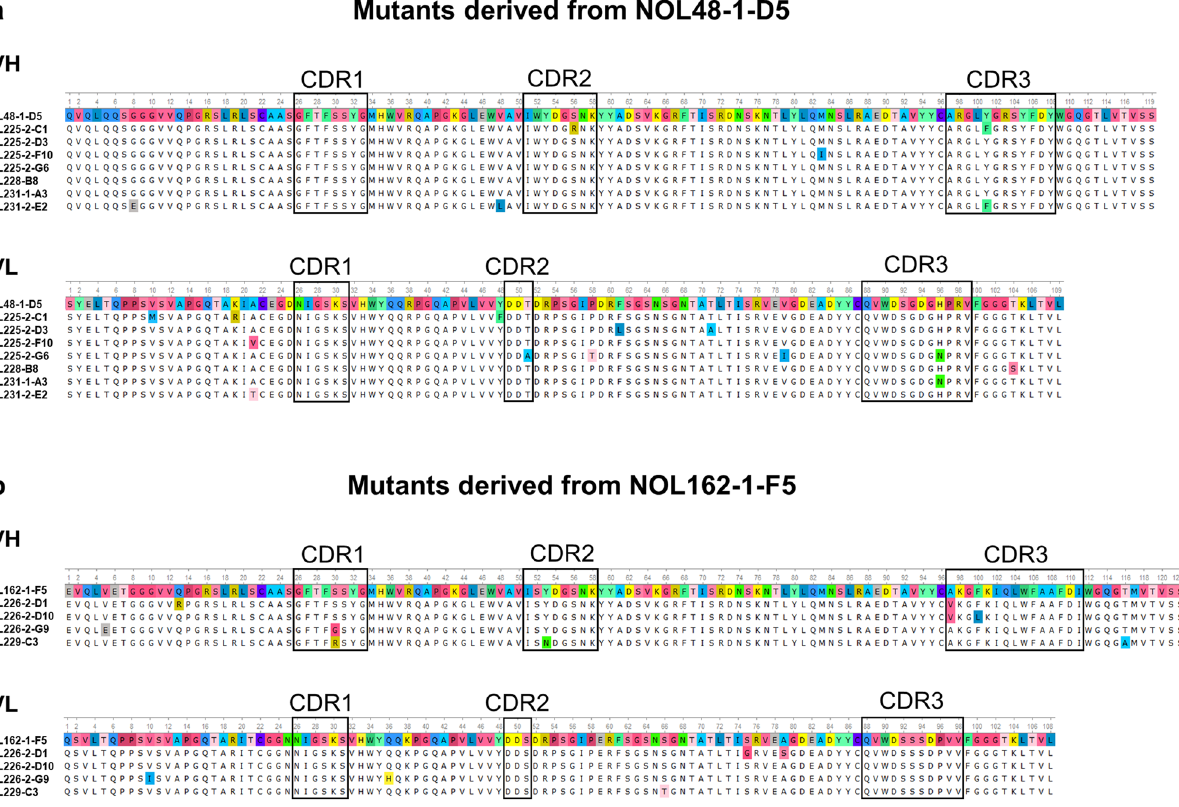
Figure 2. Sequence alignment of affinity-matured antibodies. ( a ) Alignment of the VH and VL region of mutants derived from NOL48-1-D5. ( b ) Alignment of the VH and VL region of mutants derived from NOL162- 1-F5. The CDR regions are marked in boxes. The parental sequences are set as references and amino acid substitutions in other sequences are marked in color. Alignments were constructed using Unipro